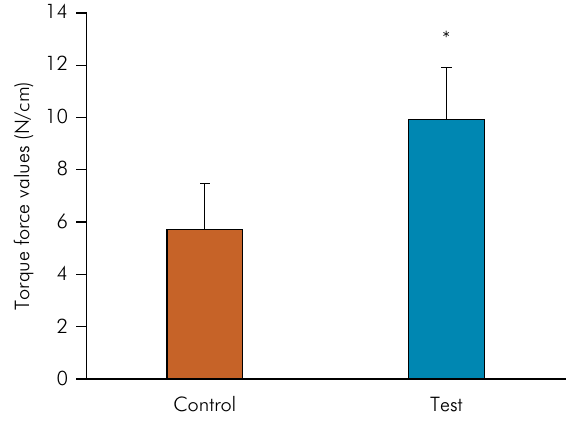
Figure 2. Biomechanical analysis of implant removal.